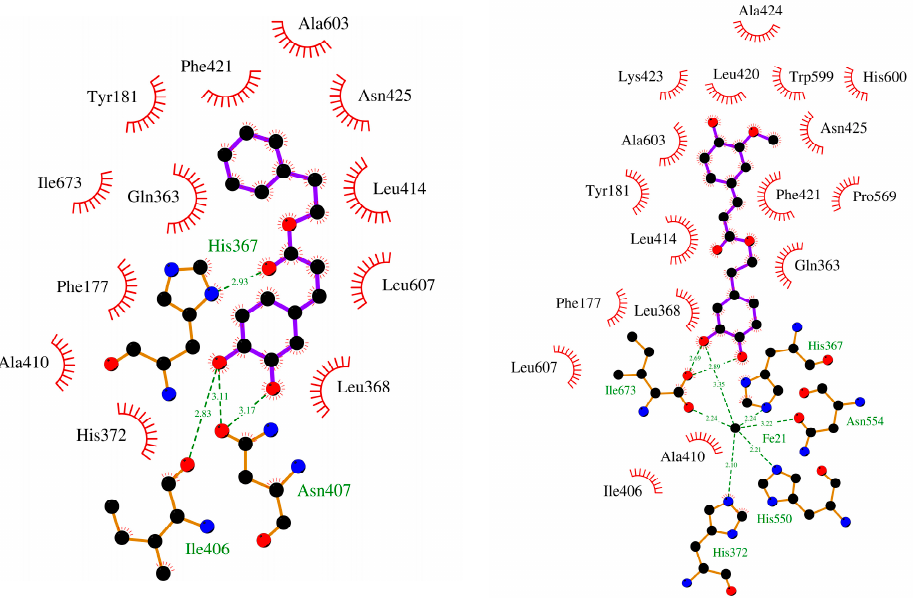
Figure 5. 3D images of CAPE ( 1a ) ( left ) and 27 ( right ) taken from LigPlot + .